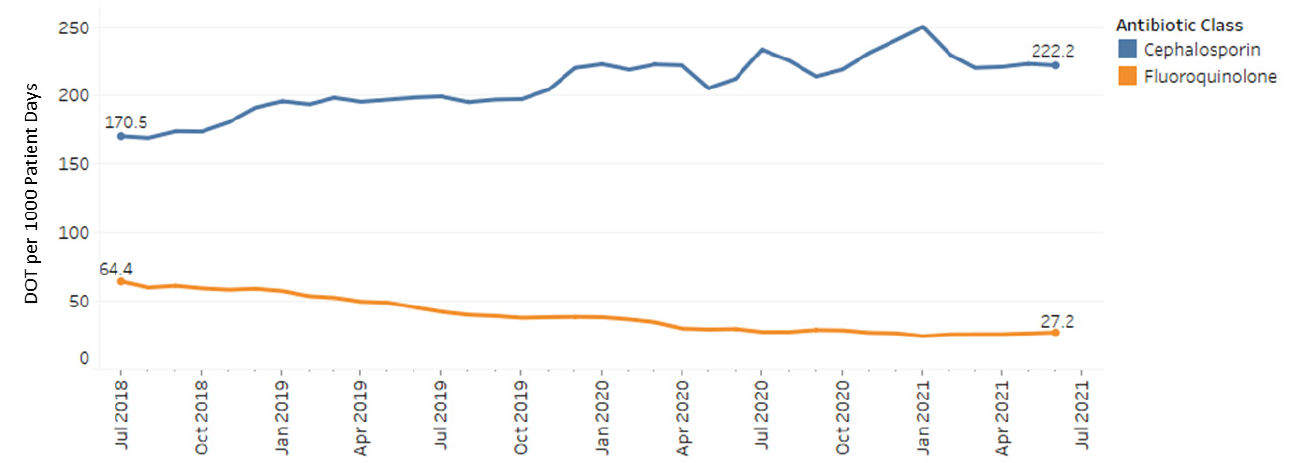
Figure 1. Cephalosporin and fluoroquinolone use July 2018–July 2021. A total of 24,214 patients had a positive result for C. difficile, which amounted to 1% of included patients in this study. At the beginning of the study period, rates of CDI were 26.5 infections per 10,000 patient days compared to 14.9 at the end of the study period (Figure 2). Overall rates of infection decreased throughout the study period by 0.37 infections/10,000 patient days per month ( p < 0.001).